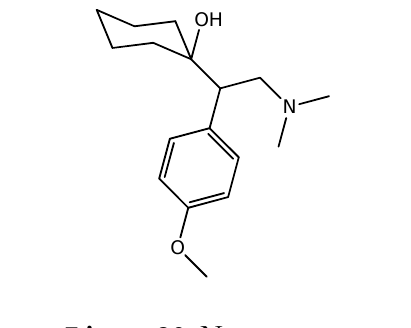
Figure 30. Neramexane.